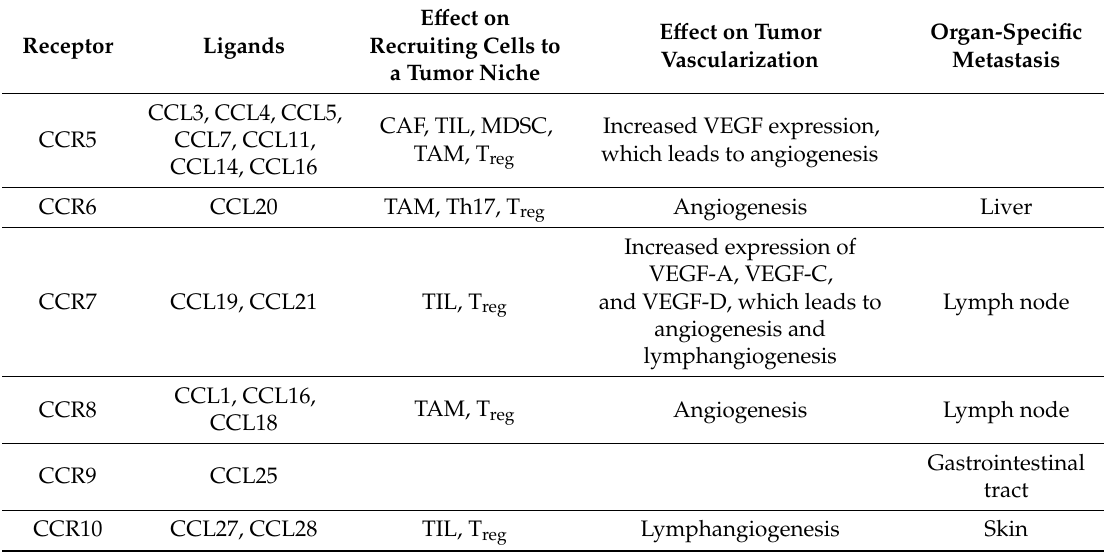
Table 4. Receptors for CC chemokines described in this review and their respective ligands and functions in a